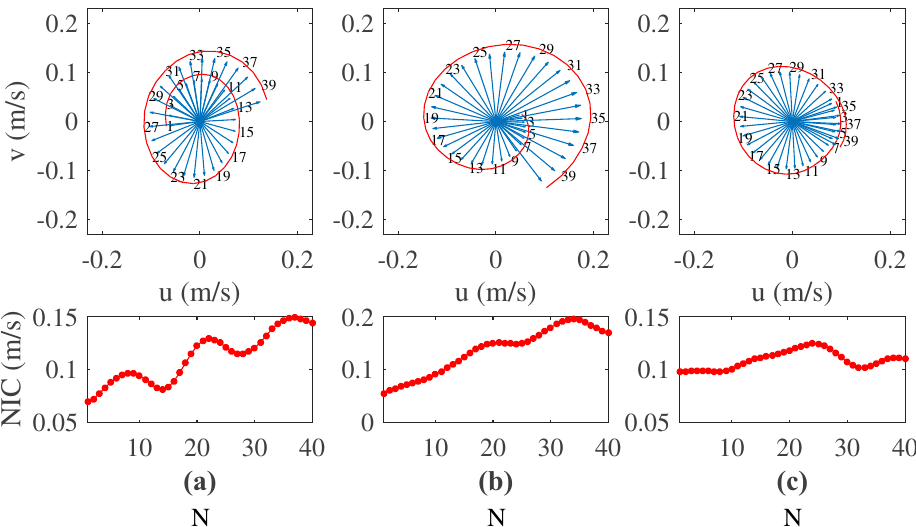
Figure 11. Variations of the NICs with time after the passage of typhoons Bebinca ( a ), Barijat and Mangkhut ( b ), and Yutu ( c ), respectively. The red line is the NICs, “N” is the serial number of the selected NICs, and the time difference between the two adjacent serial numbers is 1